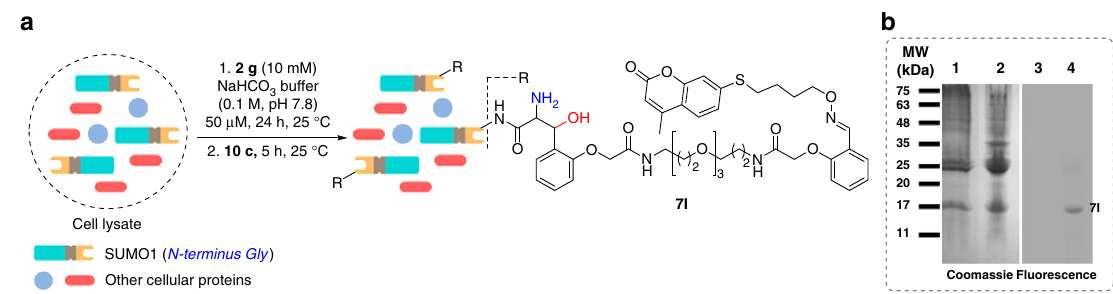
Fig. 6 Residue-speci fi c labeling of a protein in the cell lysate. a Selective labeling of N-Gly SUMO1 with coumarin tag in cell lysate. b 12% SDS-PAGE of cell lysate (overexpressed with SUMO1) and coumarin-tagged SUMO1 7l in cell lysate followed by coomassie staining and fl uorescence imaging. MW — molecular weight, Lanes 1 and 2: cell lysate before and after reaction (Coomassie); lanes 3 and 4: cell lysate before and after reaction ( fl uorescence). The band at ~17 kDa ( m/z 11.6 kDa) in lanes corresponds to the SUMO1. The band at ~17 kDa ( m/z 11.6 kDa) shown by fl uorescence imaging in lane 4 con fi rms the selective tagging of SUMO1 ( 7l ). Source data of Fig. 6 panel b provided as Source Data